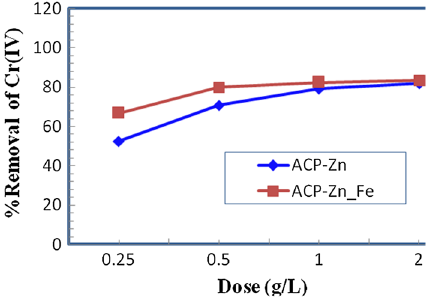
Table 3 Effect of Cr(VI) concentration on ACP-Zn-Fe